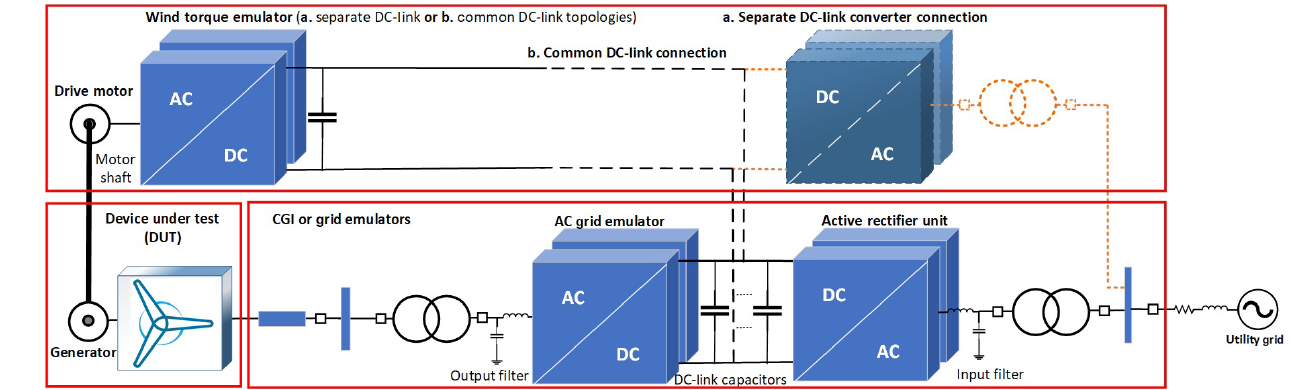
Figure 3. Proposed generic schematic diagram of a converter-based test bench. Table 1. Comparison of different concepts applied in industrial test benches.